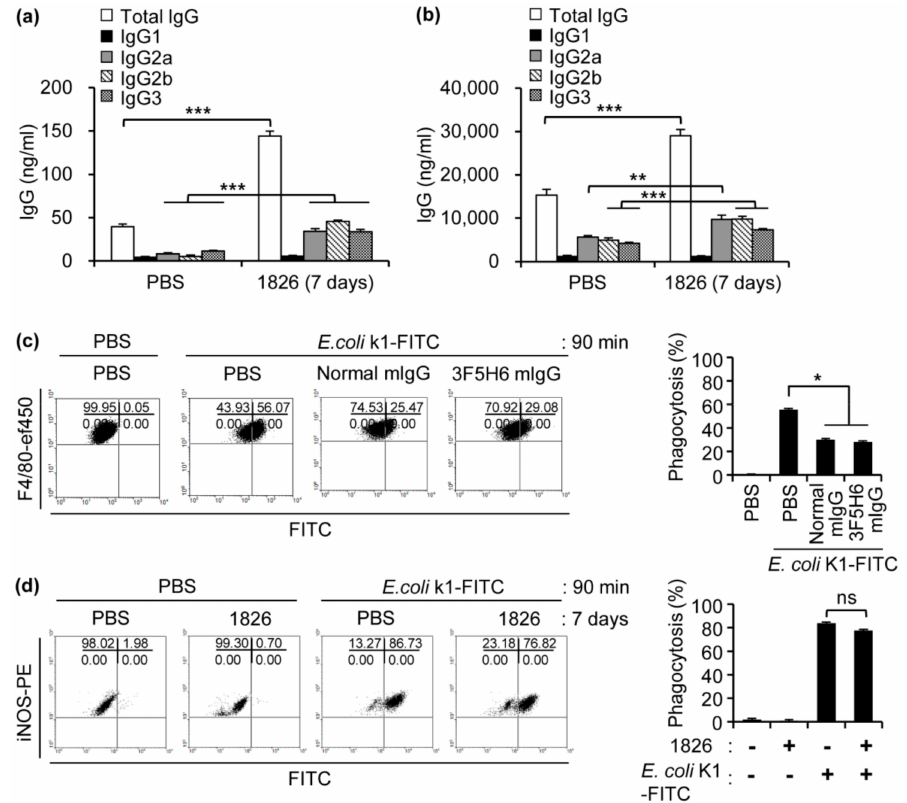
Figure 5. BALB / c mice were i.p. injected with PBS or CpG-DNA 1826 (2.5 mg / kg mouse). After seven days, the mice were sacrificed, and the peritoneal cavity supernatants and serum were harvested from the mice. The amounts of E. coli K1-reactive IgG subclasses in peritoneal cavity supernatant ( a ) and serum ( b ) were measured by ELISA using E. coli K1-coated plates ( n = 3 / group). 1826, CpG-DNA 1826. ** p < 0.005, *** p < 0.0005. ( c ) E ff ect of bacteria-reactive monoclonal antibody (3F5H6 mIgG) on phagocytosis in the mouse peritoneal cavity against E. coli K1 infection. FITC-labeled E. coli K1 cells (1 × 10 6 CFU / mL) were incubated with PBS, normal mouse IgG, or 3F5H6 mIg (10 µ g / mL) for 1 h and then 200 µ L of the mixture was i.p. injected into BALB / c mice ( n = 3). After 90 min, peritoneal cells were harvested from the mice and stained with specific markers. FSC low SSC high cells of peritoneal cells were gated, and the myeloid populations of the peritoneal cavity were gated using F4 / 80 subsets. FITC-labeled E. coli K1 uptake of macrophages was determined by flow cytometry. 1826, CpG-DNA 1826. Normal mIgG, normal mouse IgG. 3F5H6 mIgG, CpG-DNA-induced bacteria-reactive monoclonal antibody clone 3F5H6. * p < 0.05. ( d ) Analysis of E. coli K1 uptake in the mouse peritoneal cavity. BALB / c mice were i.p. injected with PBS or CpG-DNA 1826 (2.5 mg / kg mouse). After seven days, the mice were i.p. injected with PBS or FITC-labeled E. coli K1 (2 × 10 6 CFU / mouse). After 90 min, peritoneal cells were harvested, counted, and stained with fluorescence-conjugated antibodies and analyzed by flow cytometry. FSC low SSC high cells of peritoneal cells were gated, and the myeloid populations of the peritoneal cavity were gated using F4 / 80 and sorted into CD206 and iNOS subsets. FITC-labeled- E. coli K1 uptake of M1 macrophages was determined by flow cytometry. 1826, CpG-DNA 1826. ns, not